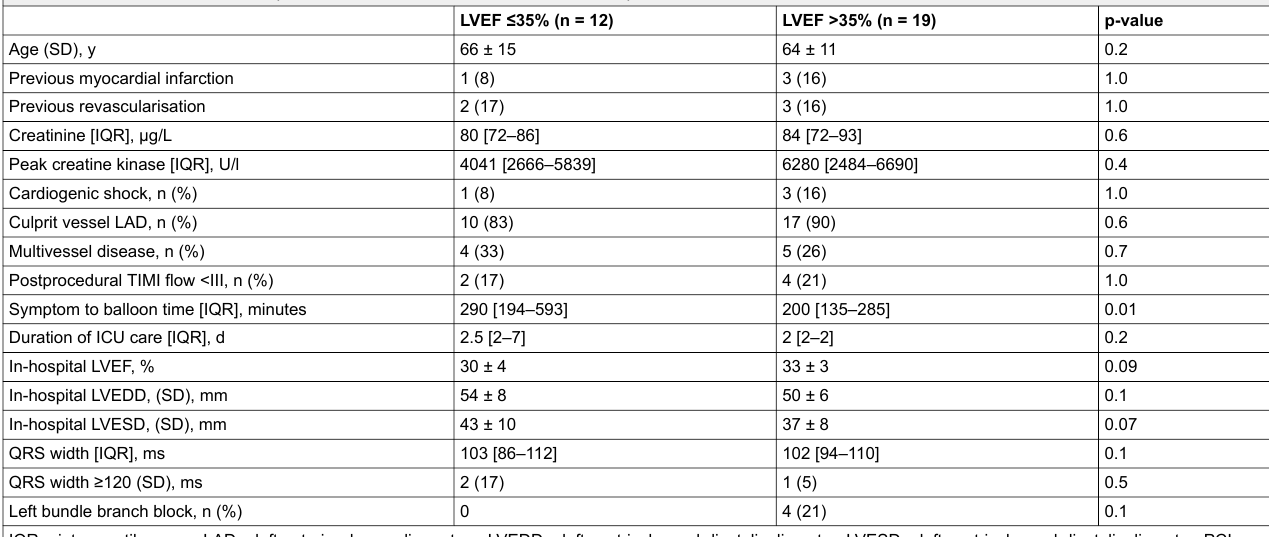
Table 2: Baseline characteristics of patients with LVEF ≤35% and >35% at follow-up.